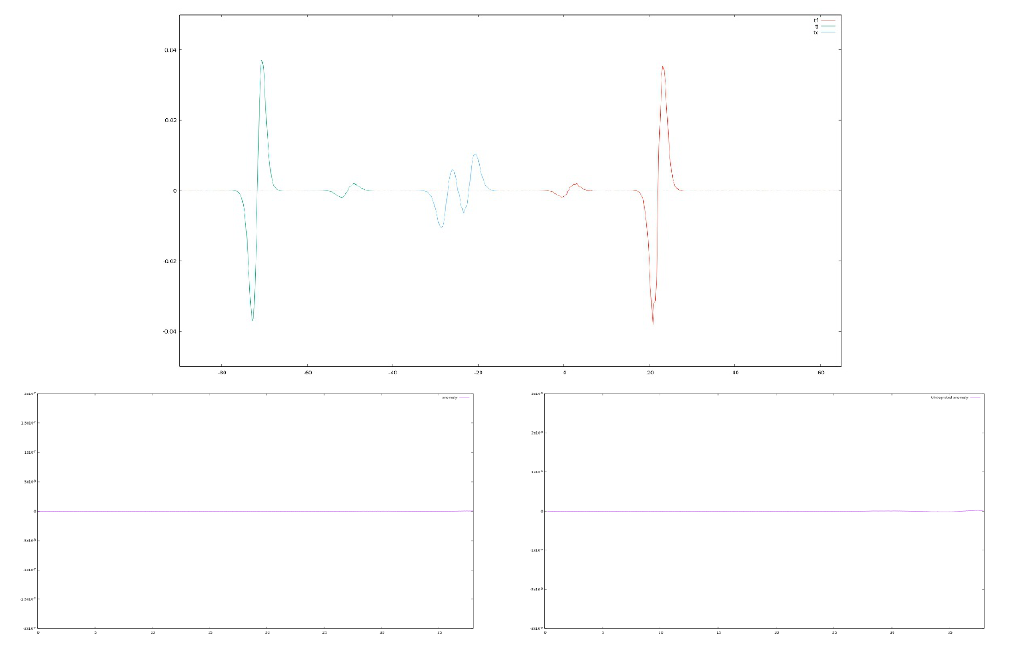
Figure 7 . Top (cid:12)gure shows the anomaly density of h 1 in (4.49); i.e. the function (cid:0) 4 q xxx (2 q 2 (cid:15) 2 q xx q tt ) plotted in x -coordinate for three successive times, t i = before collision (green), t c = collision (blue) and t f = after collision (red), for the 2-soliton of (cid:12)gure 2. Bottom (cid:12)gures show the plots of the anomaly h 1 vs. t and the t -integrated anomaly R t